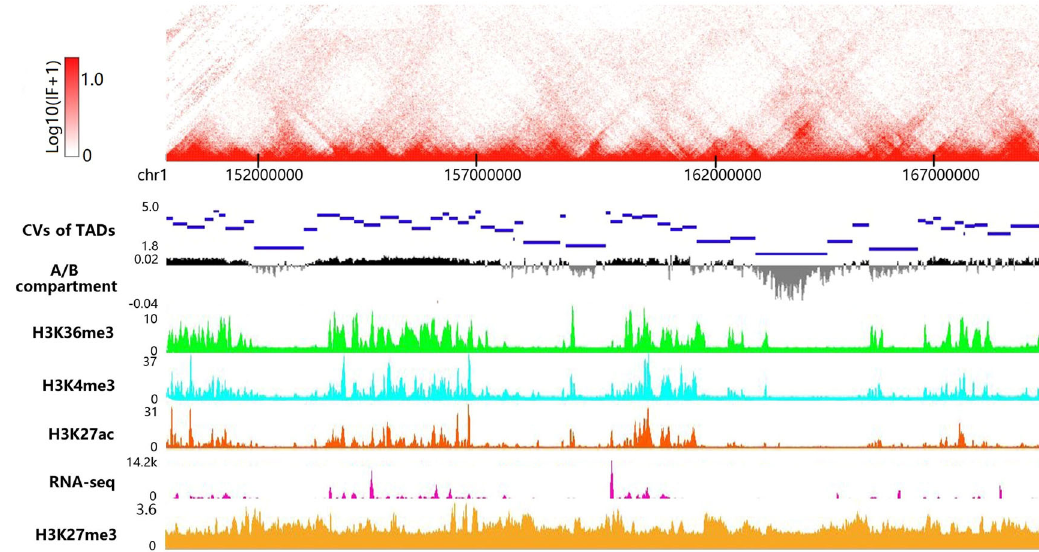
Fig. 4 Biological features of hierarchical TADs called by TAD fi t. The hierarchical TADs were called by TAD fi t on contact matrix replicates (GSM1551550_HIC001 – GSM1551554_HIC005) for chromosome 1 of GM12878 at 25K resolution, the regression coef fi cients were projected to corresponding chromatin regions according to the genomic coordinates of called TADs, and then accumulated, so that the CVs for basic TAD blocks were obtained. For A/B compartment, the fi rst eigenvector was calculated on replicate GSM1551550_HIC001 via an eigenvector command provided by juicer_tools 51 . The histone marks (H3K36me3, H3K4me3, H3K27ac, and H3K27me3) and RNA-seq data were captured online with the aid of New WashU Epigenome Browser 55 available at www.epigenomegateway.wustl.edu. This browser was also used to graphically present the above data in the form of heatmap (GSM551550_HIC001, 150 – 170 Mb) and